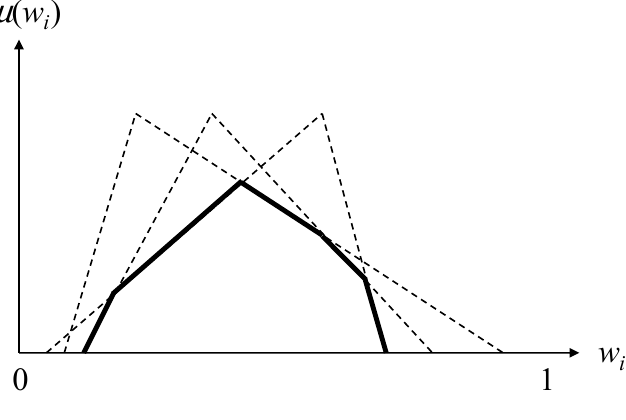
Figure 3. The fuzzy intersection (FI) result.